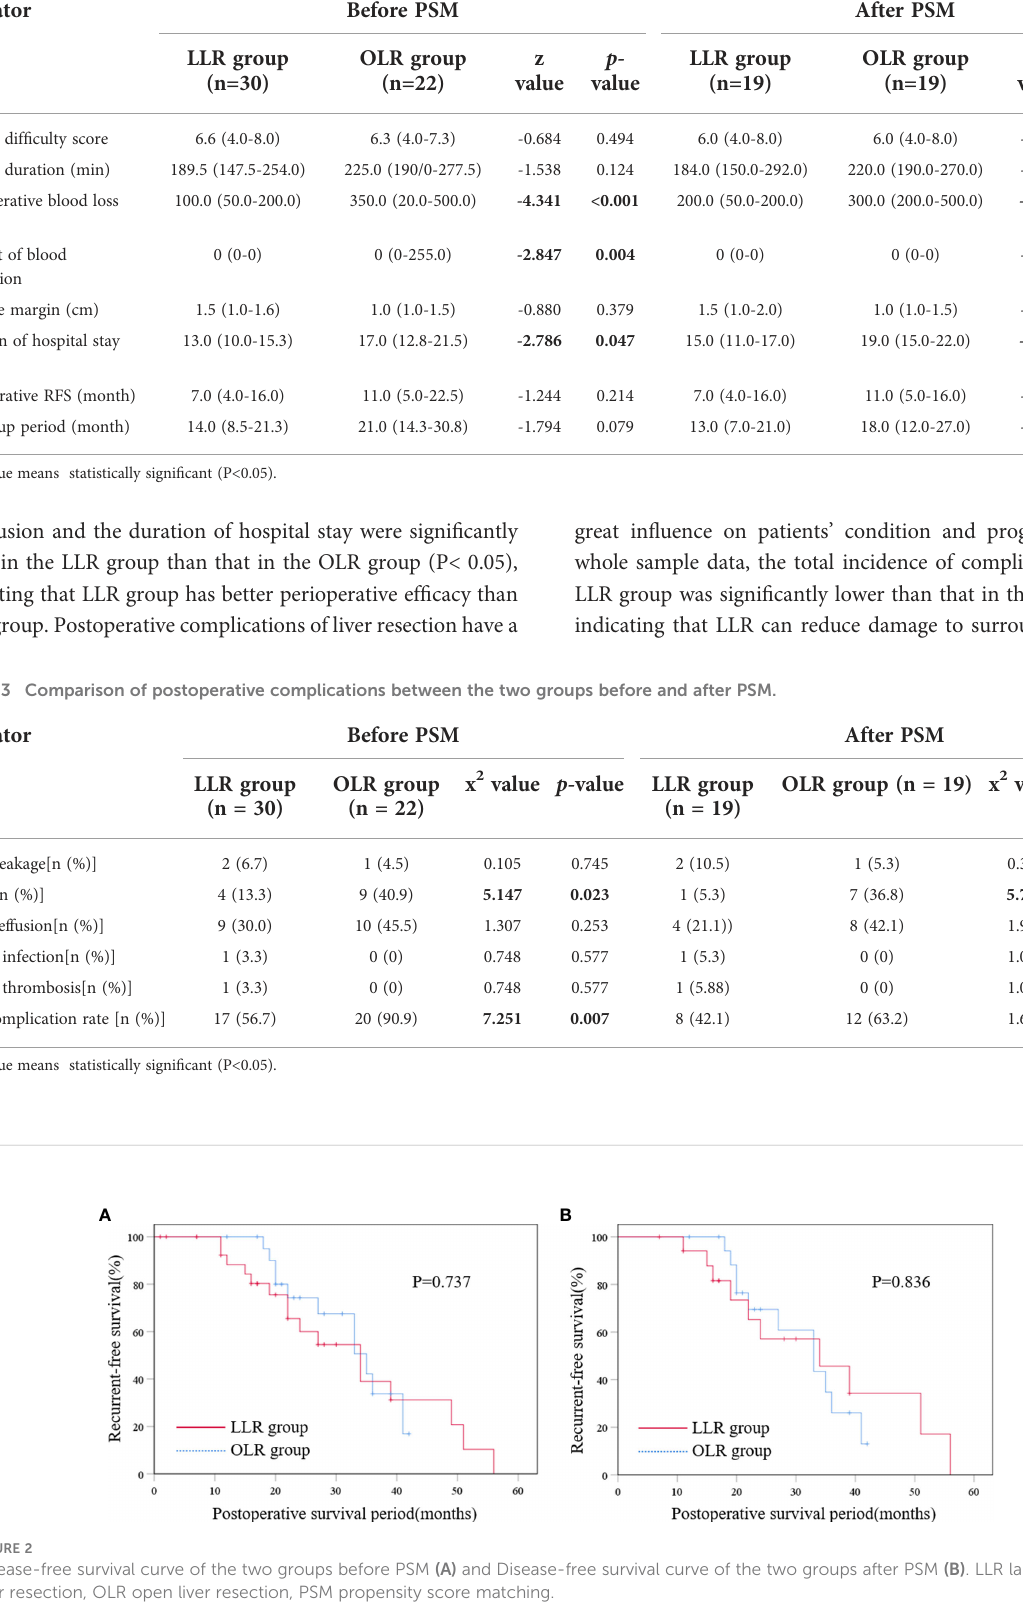
TABLE 2 Conditions of the two patient groups during the perioperative and follow-up periods before and after PSM.